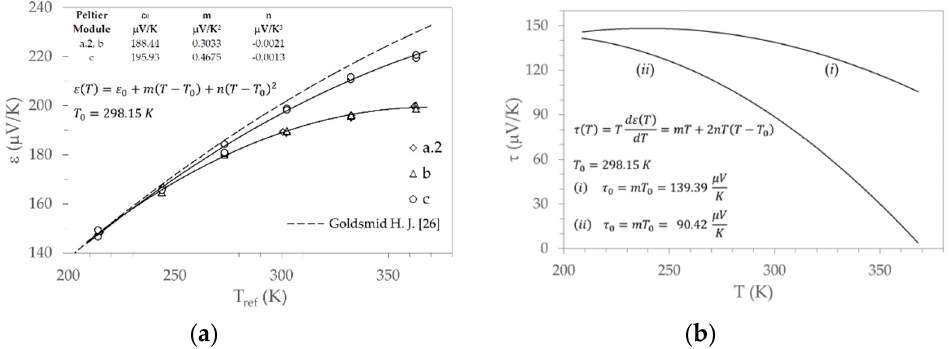
Figure 6. ( a ) Equivalent single junction Seebeck coefficients versus test reference temperature for modules a.2, b and c. The fitting equation and regression coefficients are shown in the diagram box. The solid lines represent the fit trends, and the dashed line is the theoretical trend mentioned by Goldsmid [26]; ( b ) Thomson coefficient trends for module c ( i ) and modules a.2 and b ( ii ). Parameters m and n are those shown in ( a ), and 𝜏 (cid:2868) values are the Thomson coefficients at 𝑇 (cid:2868) .